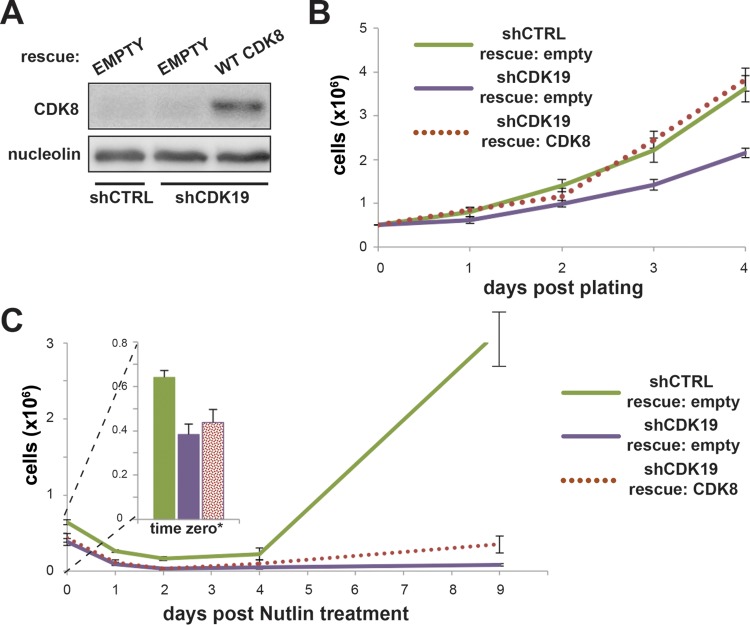
CDK8 can rescue growth defects in shCDK19 cells. (A) Western blot showing expression levels of CDK8 after transfection with empty vector or CDK8 expression plasmids. (B) Expression of CDK8 rescues the lowered growth rate of shCDK19 cells. (C) Expression of CDK8 rescues the proliferation defect in shCDK19 cells treated with nutlin-3. A low transfection efficiency (estimated to be ∼24%) likely contributes to the inability of the rescue to match shCTRL cells.